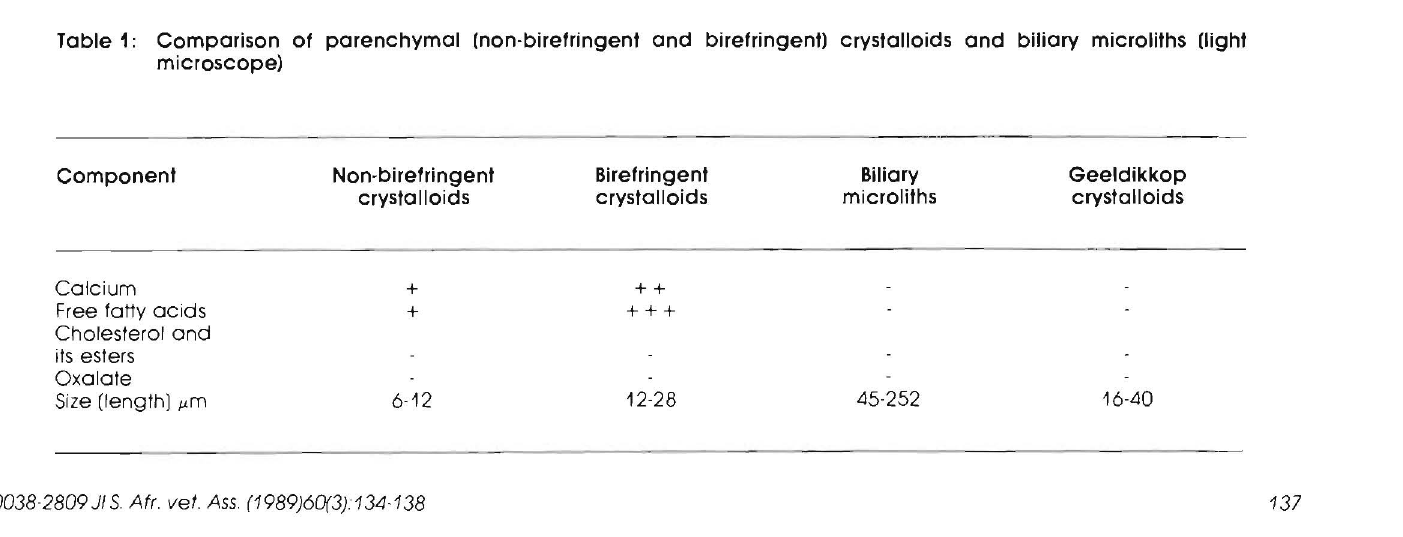
Table 1: Comparison of parenchymal (non-birefringent and birefringent) crystalloids and biliary microliths (light microscope)